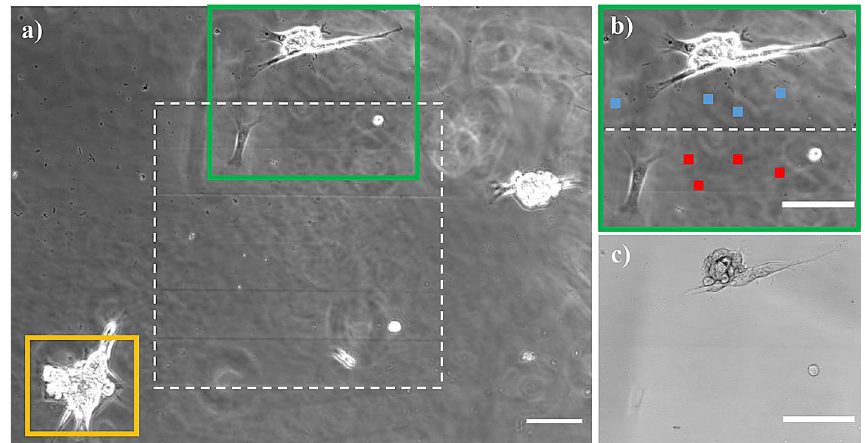
Figure 9. Hydrogel surface with cultured human fibroblasts (scale bars 100 µm). Phase-contrast image ( a ) shows the surface with the nanopillar array (white rectangle); the sputtered arrow shape (see Fig. 1) is covered by the cell marked by the yellow rectangle. Image ( b ) shows the detail of the area (green rectangle) consisting of unmodified hydrogel surface (top half) and nanopattern (bottom half) with the corresponding bright-field image given in ( c